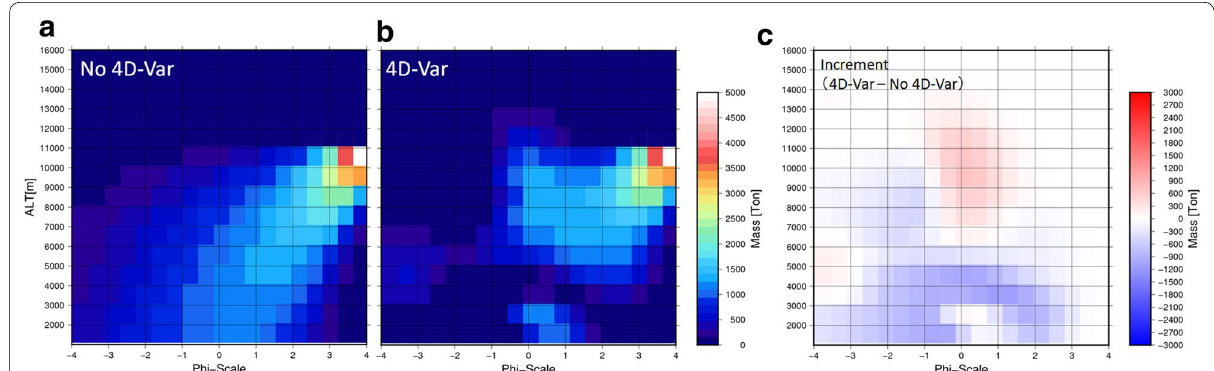
Fig. 3 Ash emission mass from eruption plumes. a First guess based on Suzuki (1983). b Analysis (corrected first guess by 4D-Var). c Analysis increment (analysis—first guess)